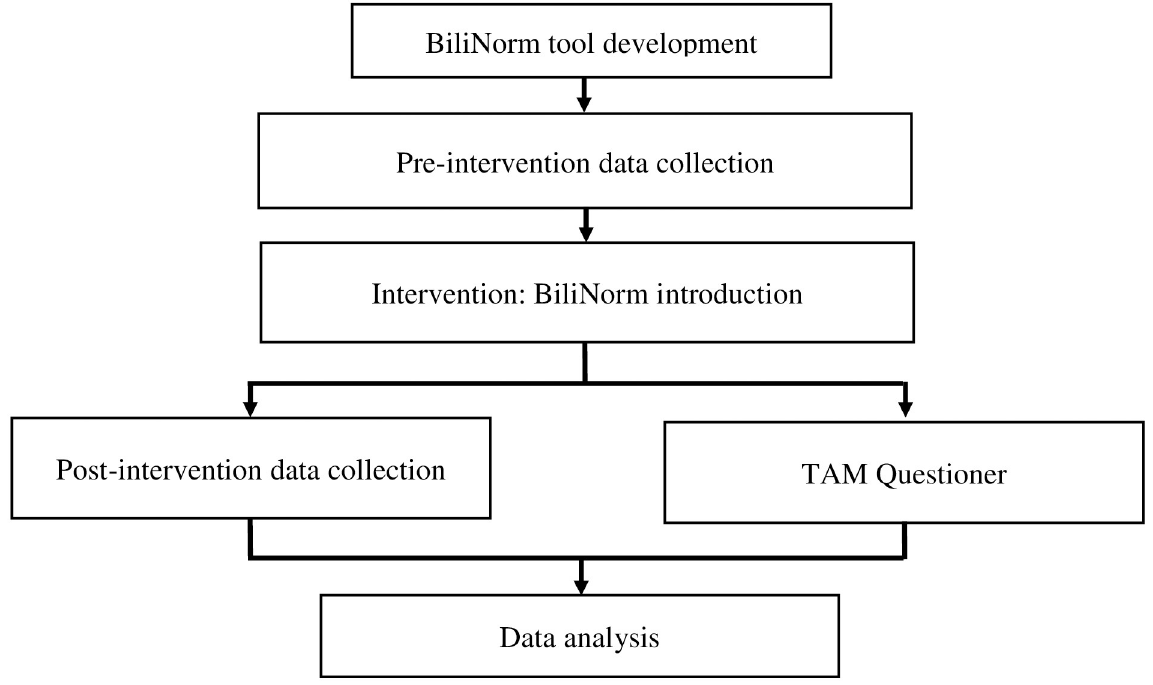
Fig 2. BiliNorm screenshots. The screenshots show the data fields required to be filled in on the input screen (A) and the results and advice given in the output screen (B) of BiliNorm. With the permission of Sampurna & Kurniwan, 2019 (https://bilinorm.babyhealthsby.org/) [6].